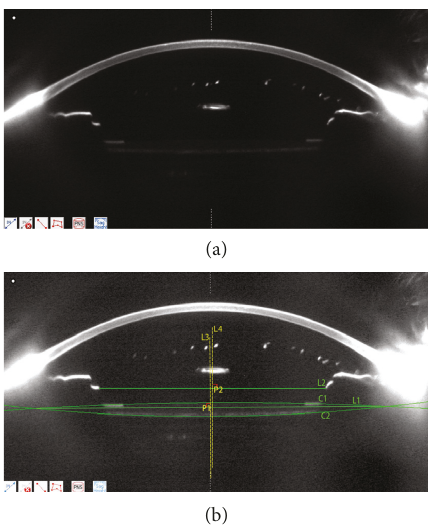
Figure 1: Anterior segment of an aphakic eye imaged by the Pentacam Scheimpflug imaging system. L3: axis on the optical center of IOL; L4: axis on the center of pupilla; C1: the best-fit-circle on the anterior surface of IOL; C2: the best-fit-circle on the pos- terior surface of IOL; L1: horizontal line of IOL; L2: horizontal line of pupilla. The tilt of IOL is defined as the angle between L3 and L4. The decentration of IOL is defined as the distance between hori- zontal coordinates of P1 and P2.